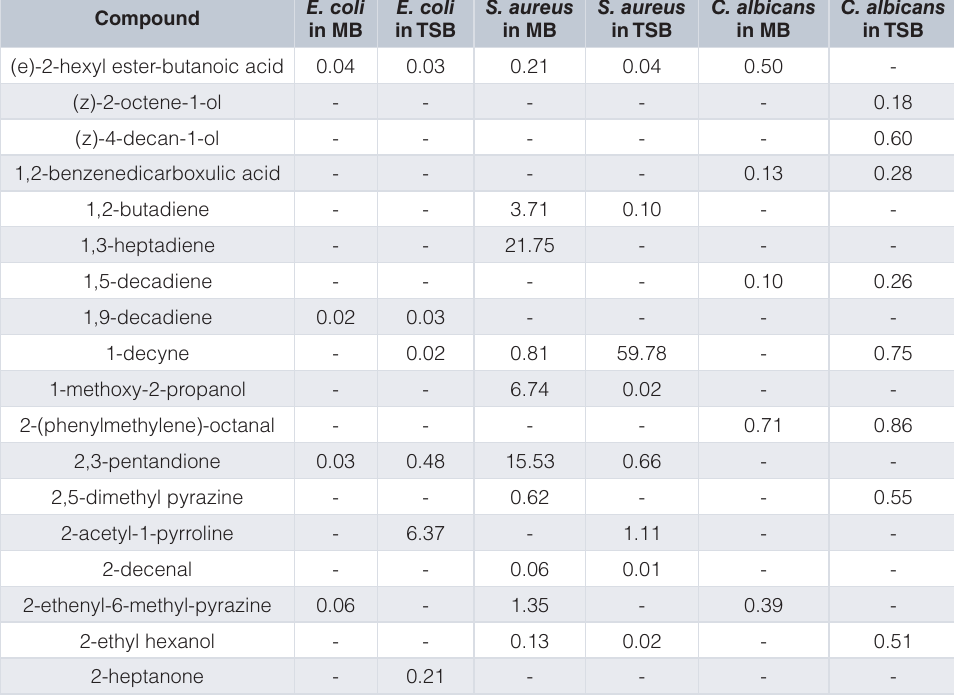
Table 3. The identified VOCs for E. coli , S. aureus and C. albicans, and the percentage of the total area that their average peak covered (peak area %), after 24 hours in MB and TSB media. In total, 16 types of ��Cs by E. coli , �6 types by S. aureus and �7 types by C. albicans were generated in this